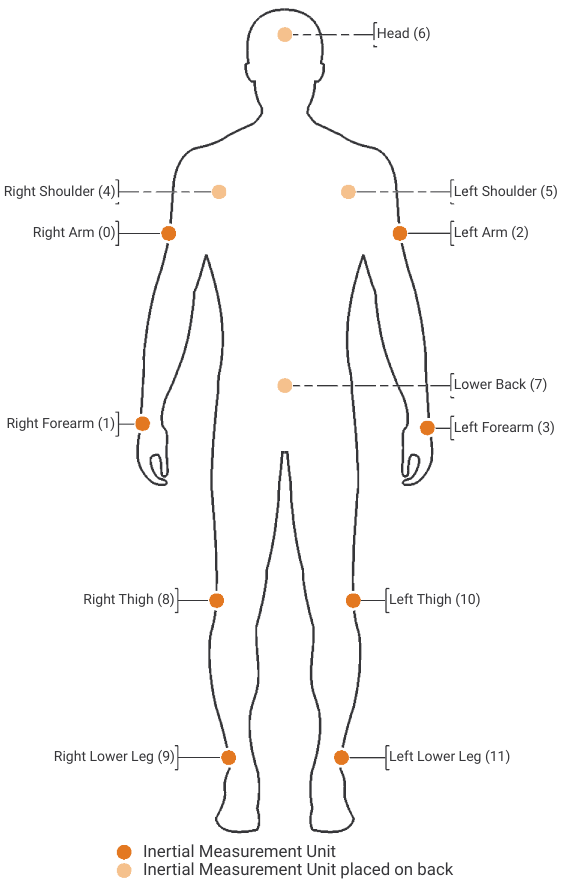
Fig. 1. Front view: sensor placement on the vest fo g p tom dataset. The numbers indicate the index of the the dataset.